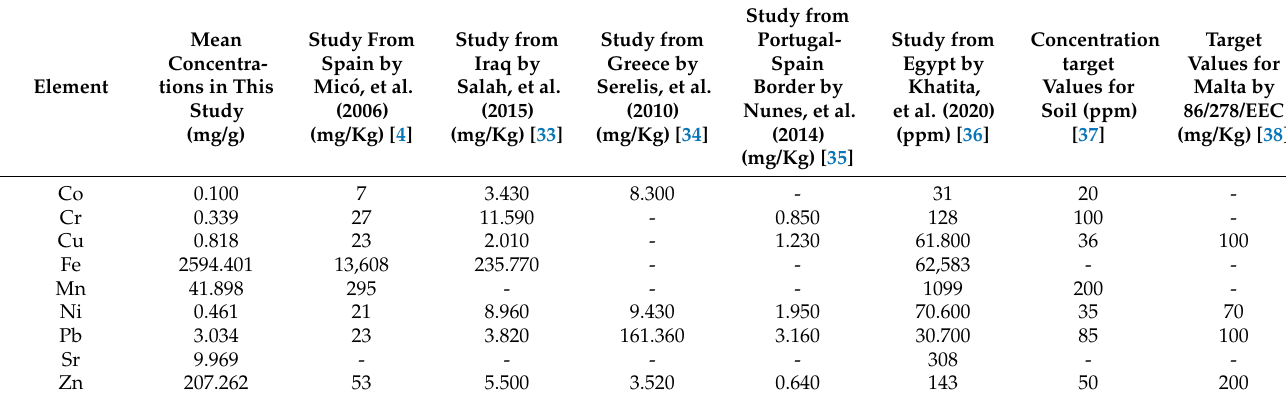
Table 6. Heavy metals contents in Mediterranean